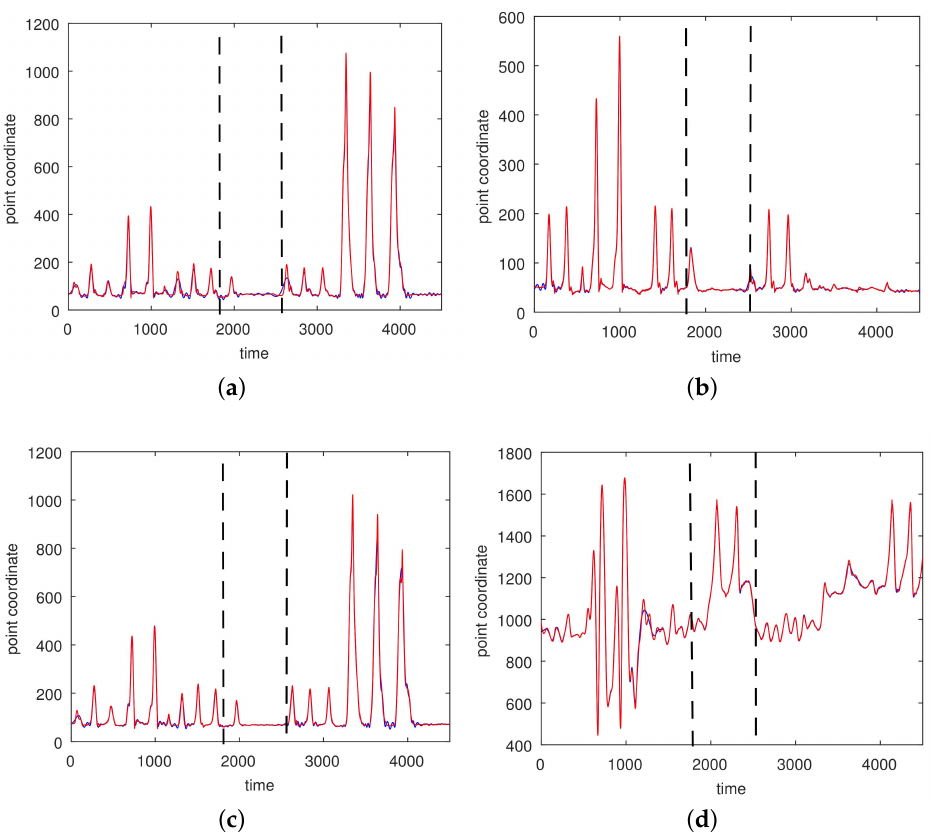
Figure 12. An approximation of the z coordinates of a complicated motion (CMU 86 Trial 2; sampled at 120Hz) by an RBF-network with three centers and 100 satellites. The motion was segmented into three intervals [ 1,1800 ] , [ 1800,2500 ] , and [ 2500,4000 ] . ( a ) Right ankle; ( b ) Left ankle; ( c ) Right heel; ( d ) Left wrist, distal. The red curves show the experimentally observed coordinates and the blue curves represent their neural approximations.